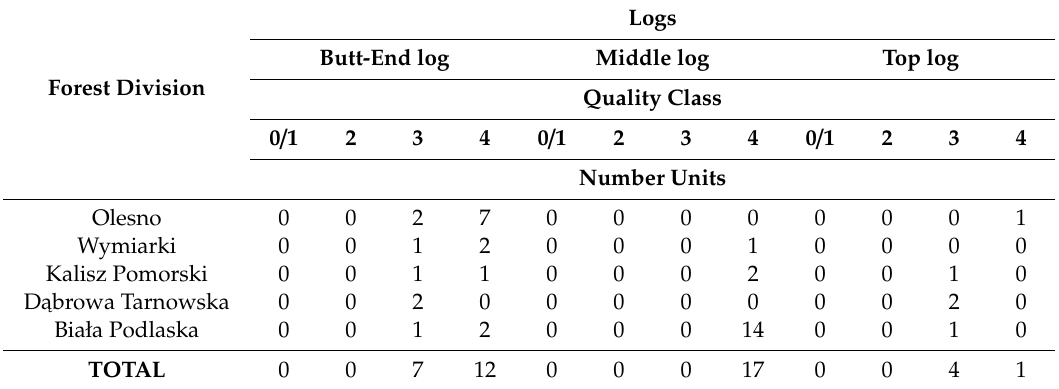
Table 20. Amount of sawn timber by defect: shakes (PN-EN